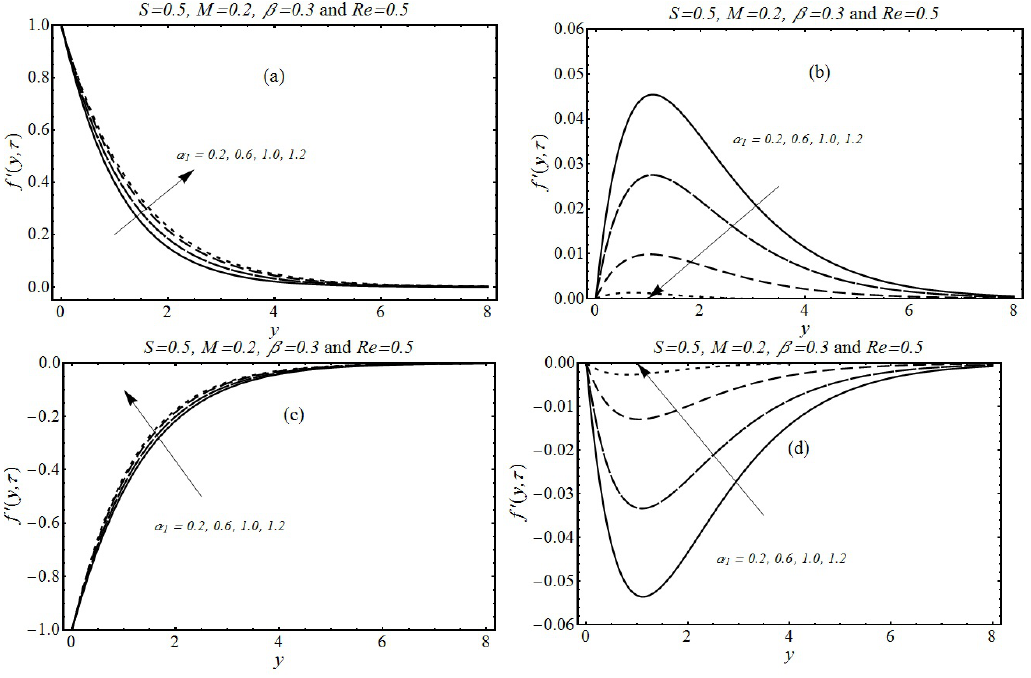
Figure 5: Effects of α 1 on velocity profile (a) τ = 8.5 π , (b) τ = 9 π , (c) τ = 9.5 π , (d) τ = 10 π .